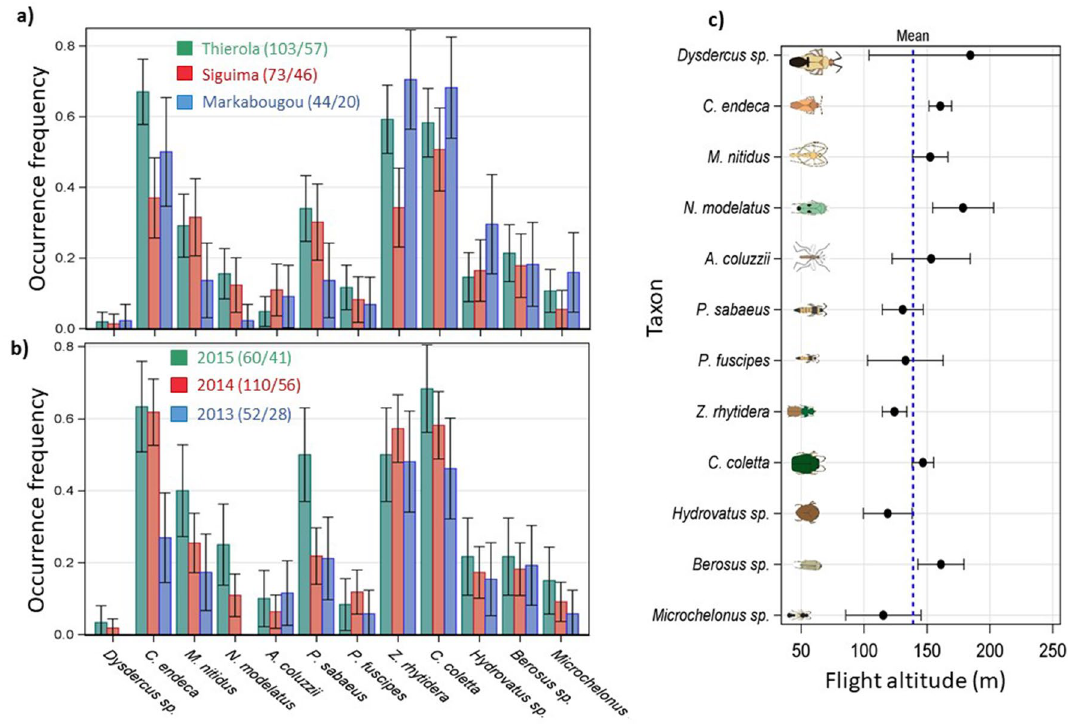
Figure 4. Spatial and annual variation in high altitude migration. Mean frequency of occurrence (+ 95% CI) of each taxon per panel by ( a ) locality (excluding Dallowere which was sampled in only 2 nights) and ( b ) year. The sampling effort in each year with respect to nets and nights is given in the legend. Between-species variation in flight altitude measured as mean panel altitude (+ 95% CI) weighted by panel density ( c ). Dotted blue line shows mean panel altitude. Note: the highest panel was typically 190 m agl, but between August and September 2015 we used a larger helium balloon and the highest panel was set at 290 m agl (see Methods). Schematic insect silhouettes are not to